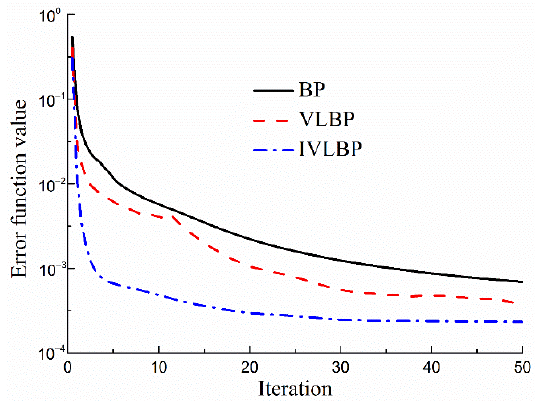
Figure 8. The comparison diagram of the three algorithms.